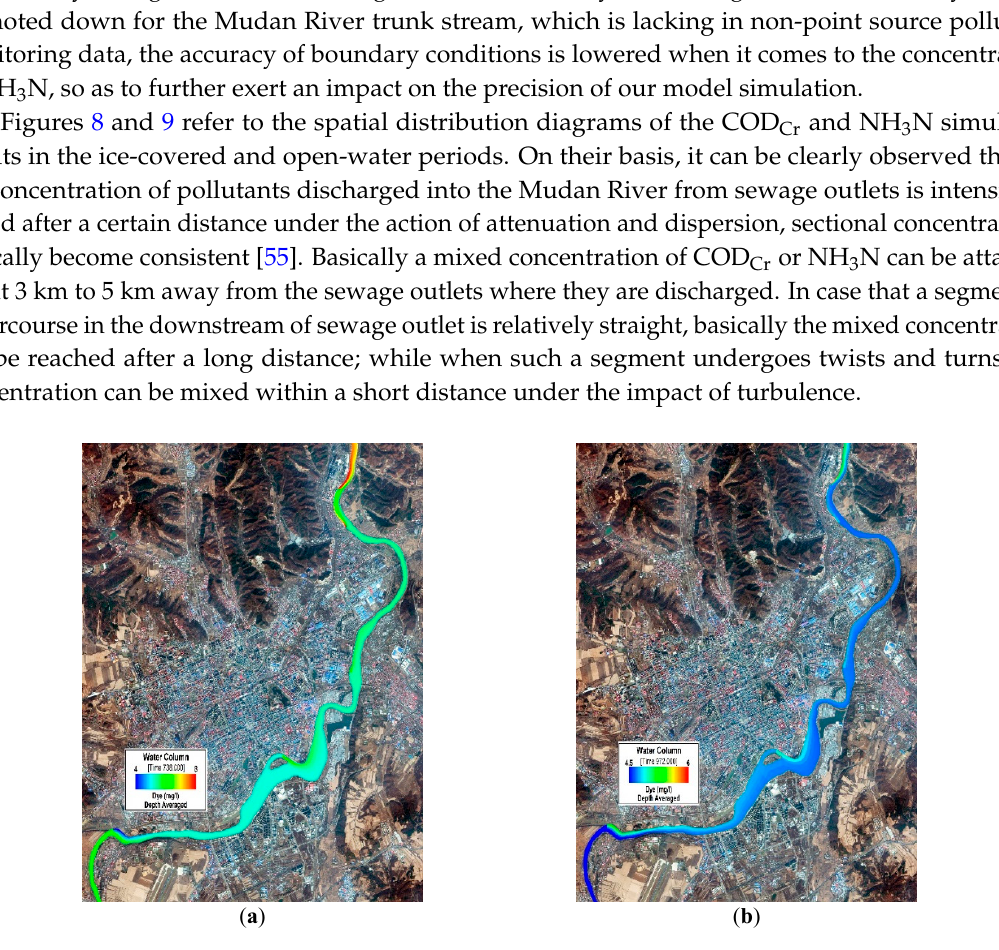
Figure 8. COD Cr concentration distribution in the Mudan River trunk stream (urban sections).